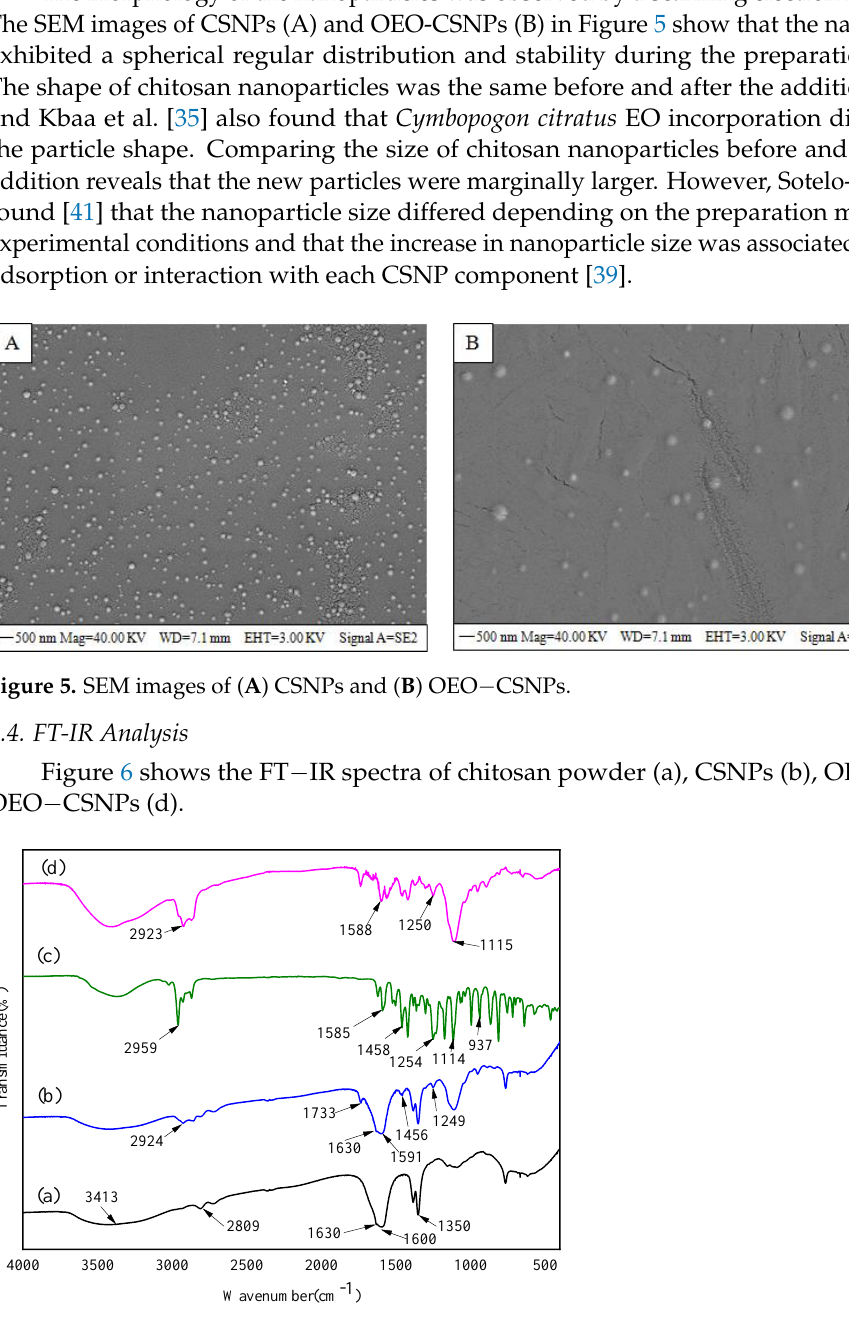
Figure 4. OEO- CSNPs zeta potential. Records 1−3 represent the first few repetitions of the experiment .